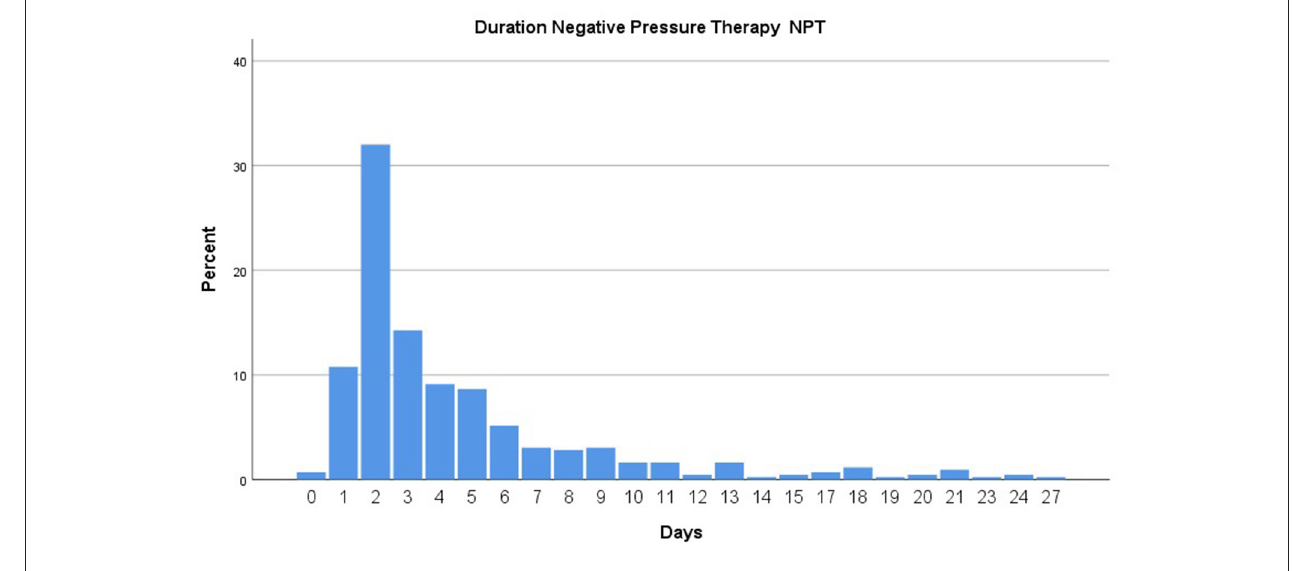
FIGURE 1 | Duration of negative pressure system in place.